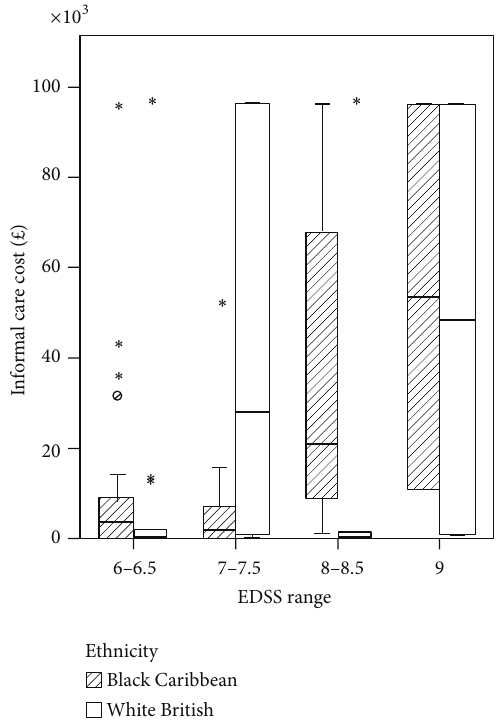
Figure 8: Box plot of informal care costs for Black Caribbean and White British